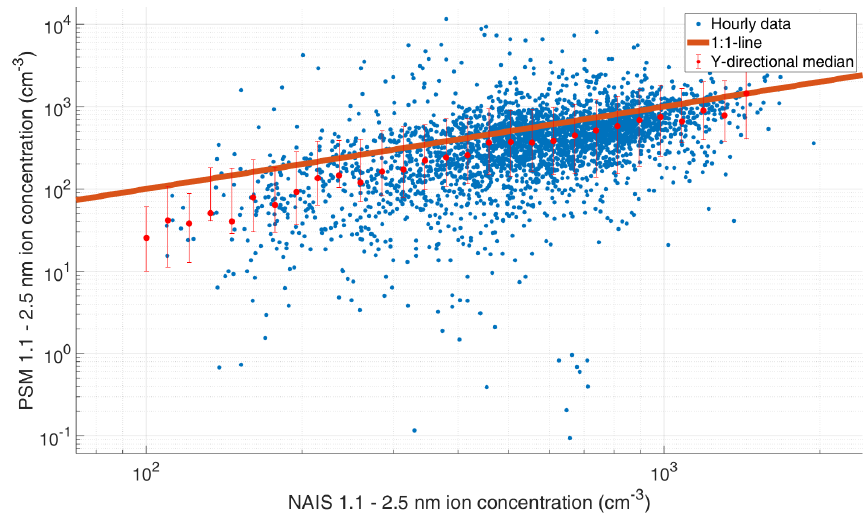
Figure 3. Comparison of 1.1–2.5nm ambient ions measured by PSM and NAIS at SMEAR II. The orange line is the 1 : 1 line, the blue data points are hourly medians, and the red points are log-normally binned y directional medians, with the red whiskers showing the 75th and 25th